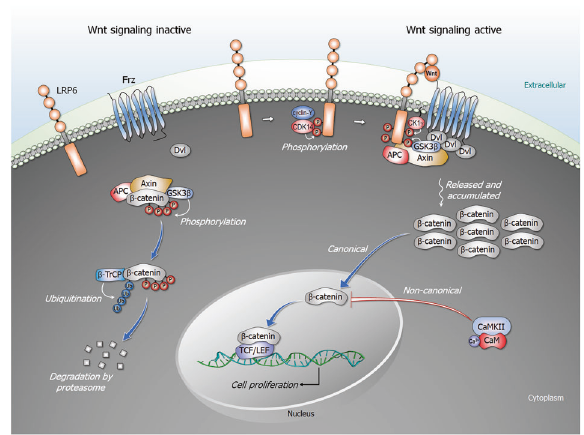
Fig. 3 The Wnt signaling pathways. In the absence of Wnt signal, the destruction complex constituted by Axin, adenomatosis poly- posis coli (APC), and glycogen synthase kinase 3 β (GSK3 β ) leads to phosphorylation of β -catenin by GSK3 β in the cytoplasm. The phosphorylated β -catenin is subsequently ubiquitinated by β -TrCP and targeted for proteasomal degradation. The canonical Wnt/ β -catenin pathway is activated by upon binding of Wnt to its Frizzled (Frz) receptor and low-density lipoprotein receptor-related protein 6 (LRP6) co-receptor. LRP6 phosphorylated by cyclin-Y/CDK14 com- plex, GSK3 β , and casein kinase 1 γ (CK1 γ ) recruits the destruction complex and Dishevelled (Dsh, Dvl in mammals) to the plasma membrane. Dvl is activated through polymerization, inhibiting the destruction complex. This results in accumulation of unphosphory- lated β -catenin in the cytoplasm and its subsequent translocation into the nucleus, leading to cell proliferation. In the non-canonical Wnt/calcium pathway, calmodulin-bound CaMKII (calcium/calmodu- lin-dependent protein kinase II) negatively regulates the canonical β -catenin/TCF/LEF signaling through phosphorylation of TCF, which inhibits β -catenin/TCF-mediated Shh pathway can involve canonical or non-canonical signaling. The fi rst is receptor ligand-dependent when Shh binds to Ptch (a 12-transmembrane protein) at the membrane; the second is through downstream smoothened (Smo). 32 Smo regulates Gli transcription factors processing and activation, which activate target genes. Non-canonical activation is Gli-independent. Hedge- hog signaling upregulates multiple proteins, including N-Myc (a member of the Myc family), forkhead box M1 (FoxM1), and Cdc25B, which activates the cyclin-dependent kinase CDC2 . It also upregulates CCND1 , CCND2 , and CCNE . Cyclin-D1, cyclin-D2, and cyclin-E which drive cell-cycle progression at the G1/S phase, while FoxM1, cyclin-B1, and Cdc25B act at the G2/M (mitotic) phase. Thus, hedgehog signals drive cell-cycle progression through multiple cell cycle regulators. Notch signaling Notch signaling takes place via cell-cell communication, where transmembrane ligands on one cell activate those of the other. The cleaved receptor is translocated to the nucleus. 33 Notch intracellular domain (NICD) forms a trimeric complex with CSL (CBF1, Suppressor of Hairless, Lag-1; a transcription factor that activates genes downstream in the Notch pathway) and Mastermind-like (MAML) transcriptional coactivator, which con- verts CSL from a repressor to an activator and initiates transcription of Notch downstream target genes. In the absence